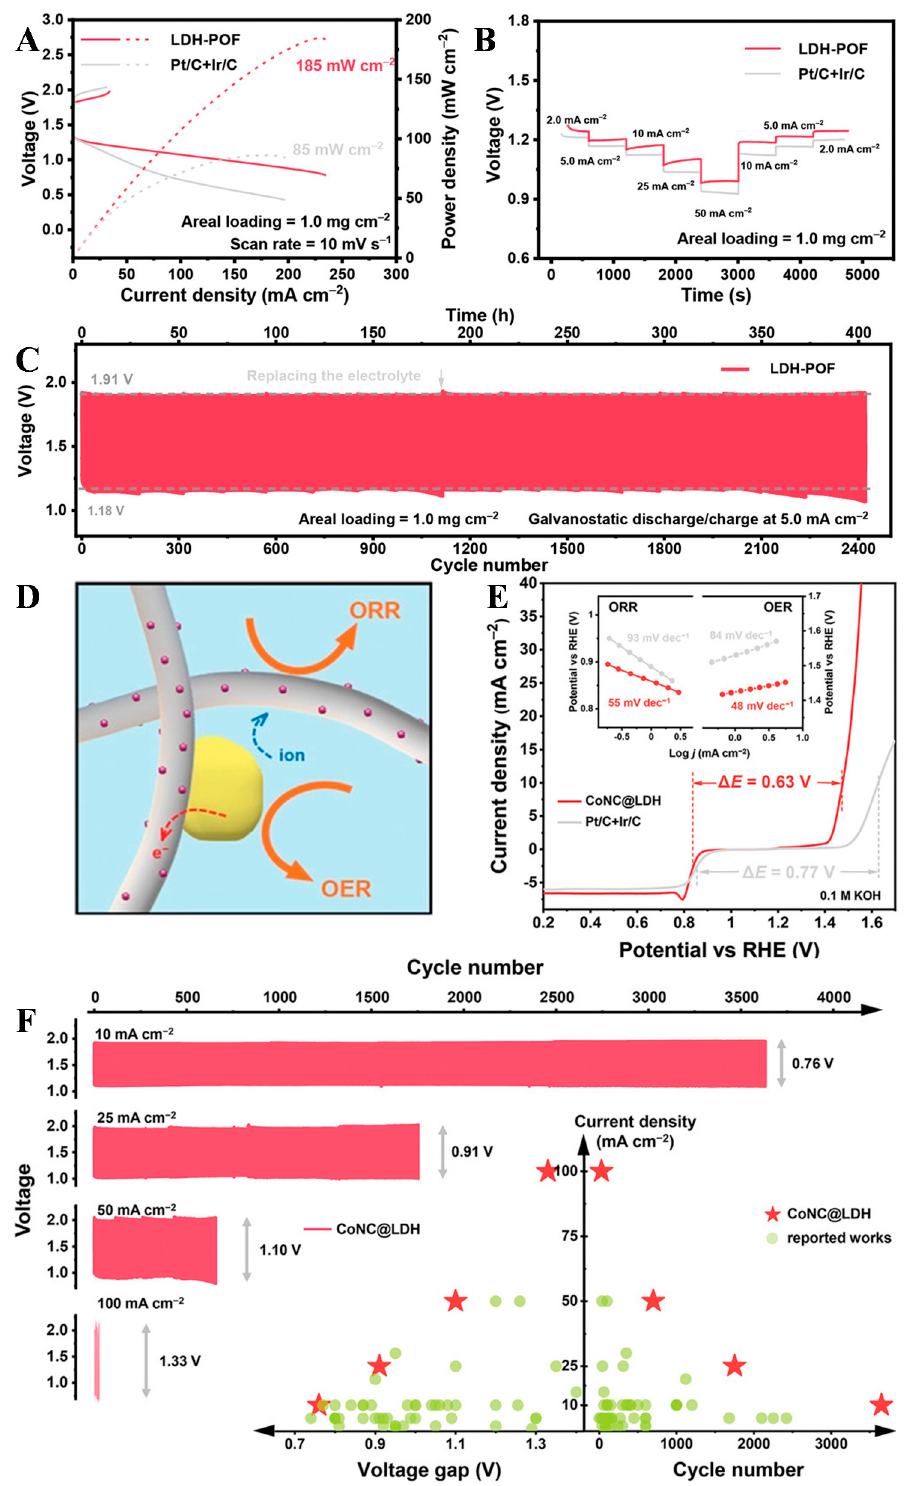
Figure 15. ( A ) Charge and discharge polarization profiles and discharge power density, the electrolyte was 6.0 M KOH aqueous solution containing 0.20 M Zn(CH 3 COO) 2 ; ( B ) Rate performances of the LDH-POF and Pt/C+Ir/C cathodes; ( C ) Galvanostatic cycling curves at 5.0 mA cm − 2 of the LDH- POF and Pt/C+Ir/C cathodes [230]. Copyright © 2020 WILEY-VCH Verlag GmbH & Co. KGaA, Weinheim. ( D ) Schematic diagram of the synergy between each component in the CoNC@LDH elec- trocatalyst; ( E ) Bifunctional performance evaluation and comparison, the inset is the corresponding Tafel plots for ORR and OER, respectively at 1600 rpm in 0.1 M KOH alkaline electrolyte; ( F ) Long- term durability evaluations on rechargeable ZABs [231]. Copyright © 2021 Wiley-VCH GmbH.